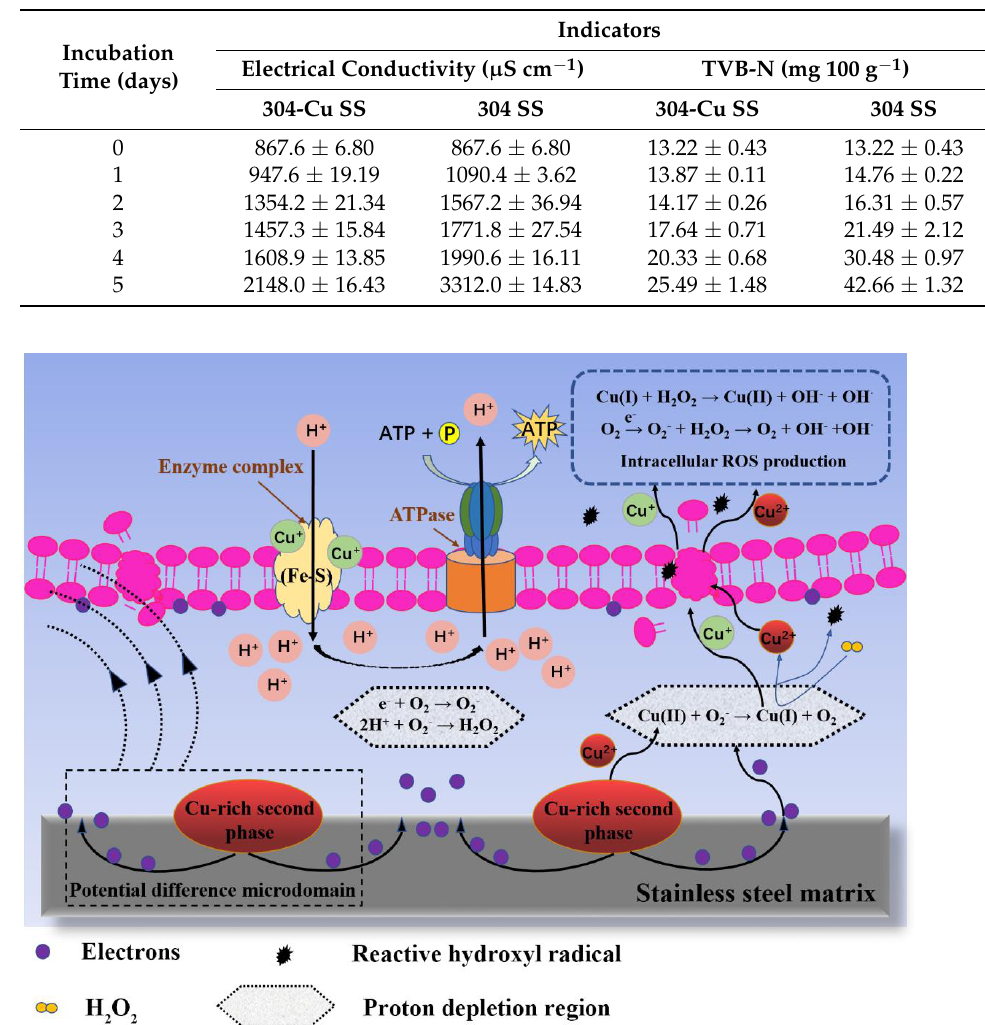
Figure 8. Schematic illustration of the bacteria-killing process of Cu-bearing stainless steel